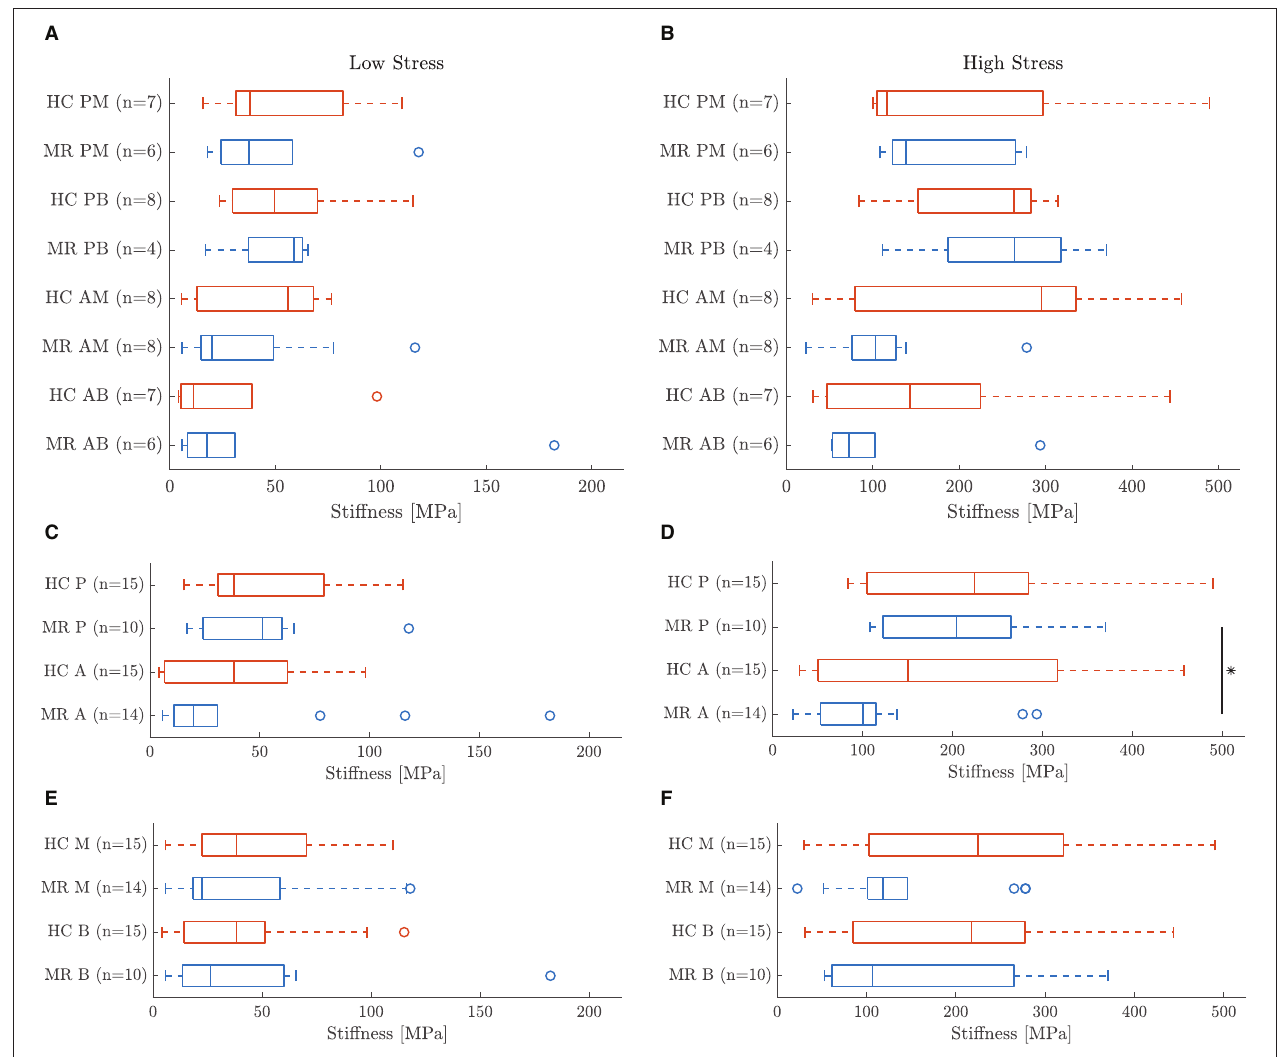
FIGURE 10 | Boxplots of the chord sample stiffness at (A,C,E) low and (B,D,F) high stress. Chords are grouped (A,B) per chordal type, (C,D) per leaflet type and (E,F) per insertion region. *Indicates a statistically significant difference ( p <